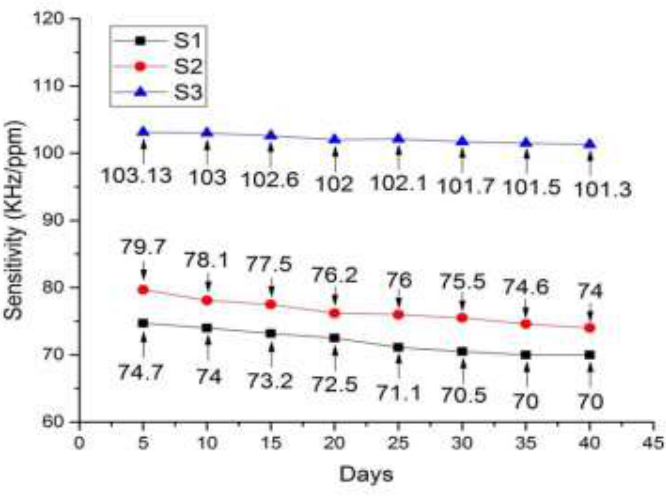
Figure 9: A dropping frequency shift of all S1, S2, and S3 sensors at a time for various reduction rates (0.063%, 0.07%, and